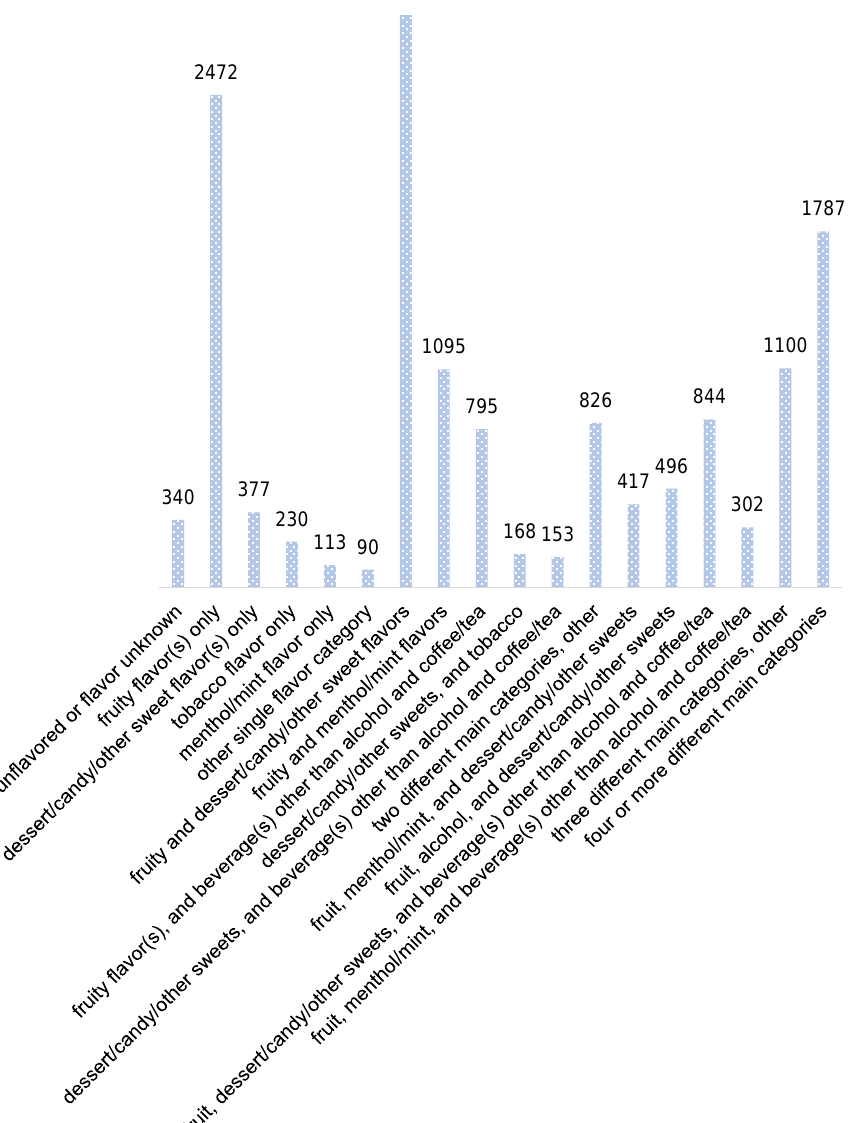
Figure 2. Frequencies of E-liquids Based on Flavor Description (Product Total N = 14,477).